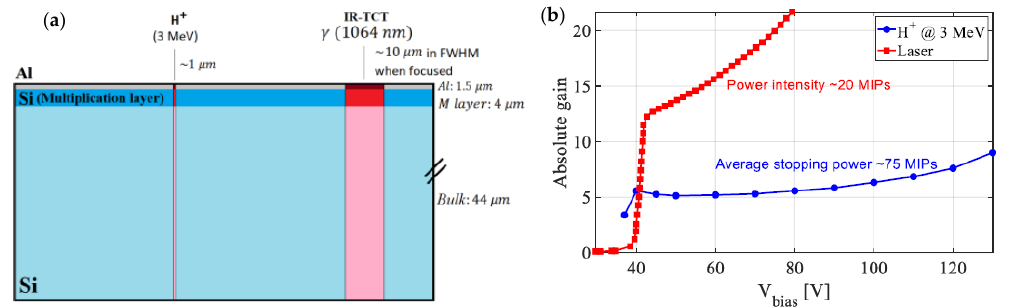
Figure 2. ( a ) LGAD structure and details of IBIC and TCT measurements (Al: aluminum layer; M: multiplication layer; figure not to scale). ( b ) Absolute gain curves obtained by IBIC and TCT with IR-laser.